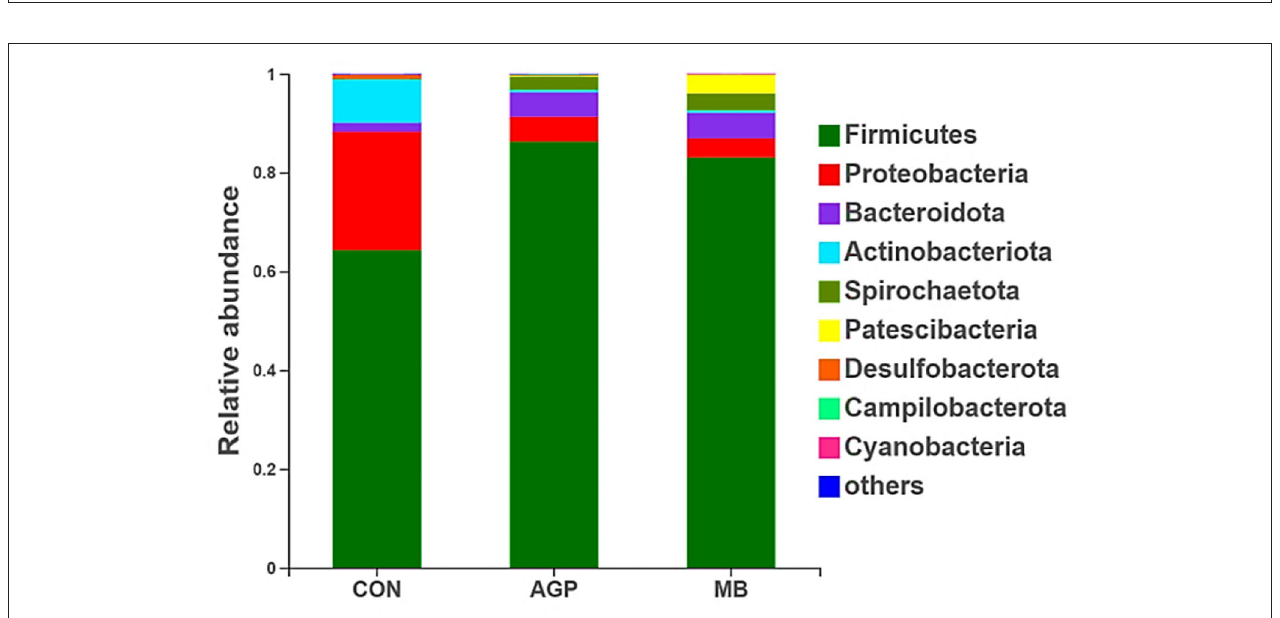
FIGURE 3 | (A) Principl coordinates analysis (PCoA) of microbial composition in the cecal digesta of weaned piglets (based on the weighted_normalized_unifrac distance). (B) Analysis of hierarchical clustering tree on OTU level showed that the microbial composition of CON group had clearly distinct with the other two groups as they located distributed almost in another branches. CON, basal diet; AGP, basal diet + 20 mg/kg flavomycin + 50 mg/kg quinocetone; MB, basal diet + 50 mg/kg Macleaya cordata extract + 1,000 mg/kg benzoic acid.